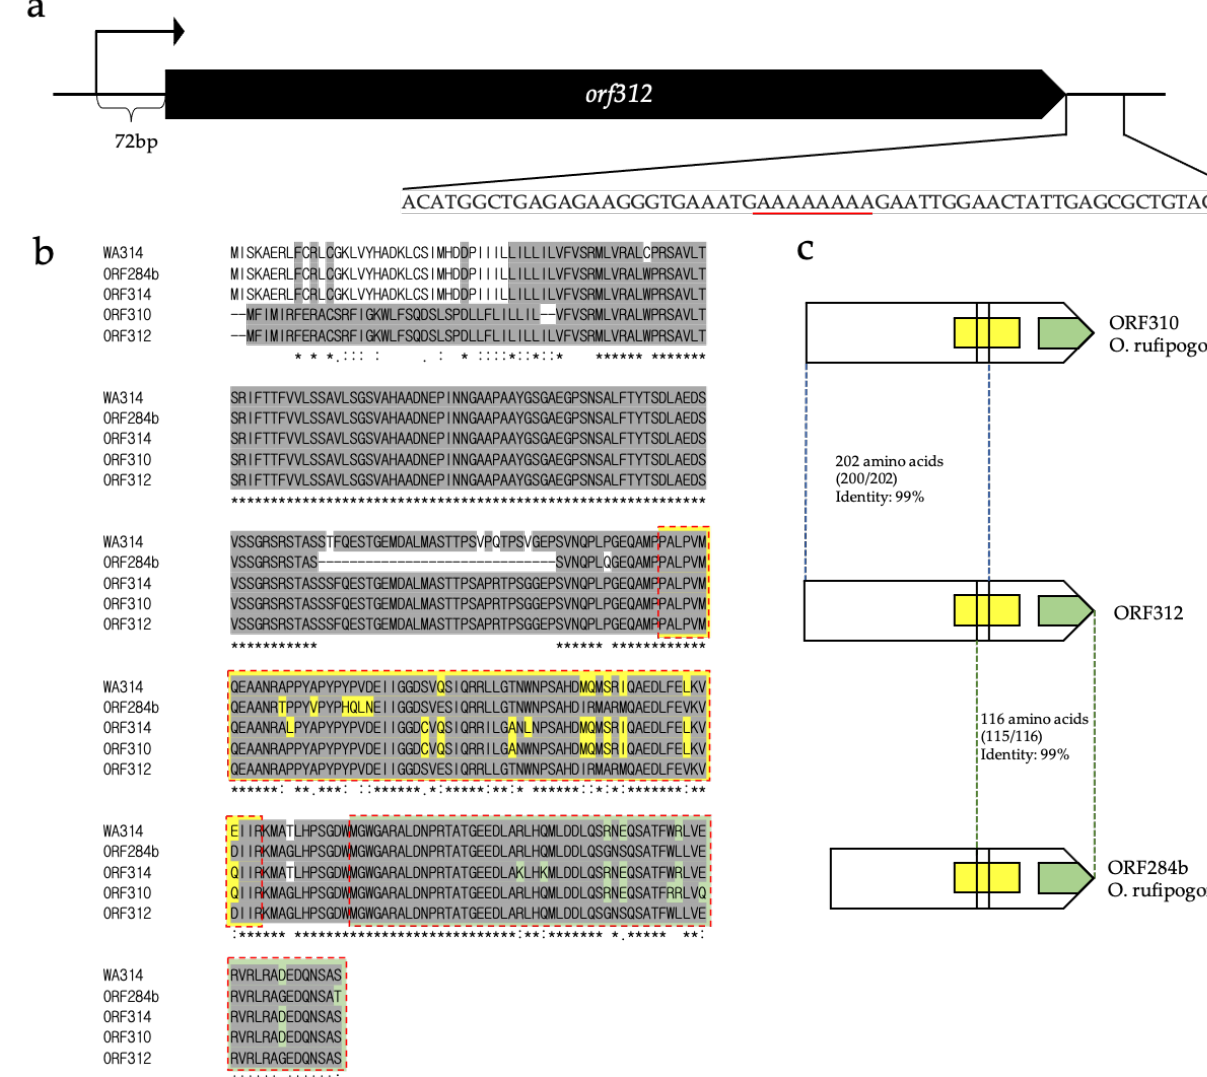
Figure 5. Transcripts and chimeric structure analysis of orf312 . ( a ) 5′ terminal of the orf312 transcripts. The black lines indicate orf312 up and downstream sequences, and the black box indicates the coding sequence for orf312 . The 5′ terminal of the orf312 transcript is marked with arrows and the poly (A) sequence from downstream sequences is marked by red line. ( b ) Multiple protein sequence alignment with similar structures. The grey color shows completely matching sequences. The yellow and green boxes indicate COX11-interaction region 1 and 2, respectively; ( c ) chimeric structures of ORF312 protein. The N terminal 202 amino acids (1–202) show 99% similarity to ORF310. ORF310 has two amino acid deletions compared to ORF312, and the C terminal 116 amino acids (197–312) is 99% identical to ORF284b, only the last amino acid is different in ORF284b. The numbers in brackets show the number of identical amino acids/the number of total amino acids, and the yellow and green boxes represent COX11-interaction regions 1 and 2, respectively.